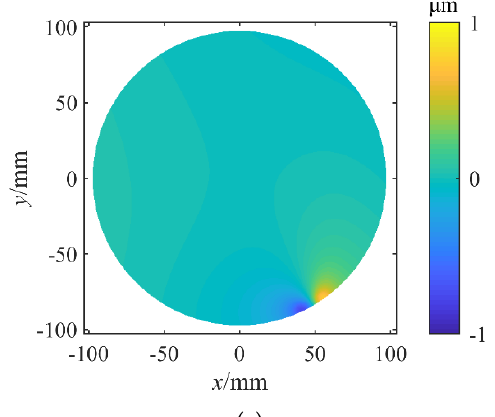
Figure 10. Wafer deformations under unit stress load on one subarea ( a ), its adjacent subarea ( b ), and their difference ( c ) when the number of subareas was 525.